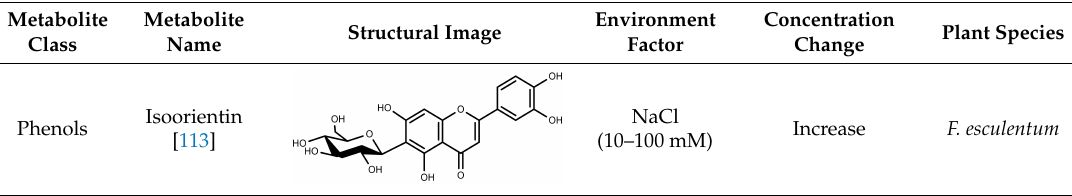
Table 6. Soil salinity change on the content of various plant